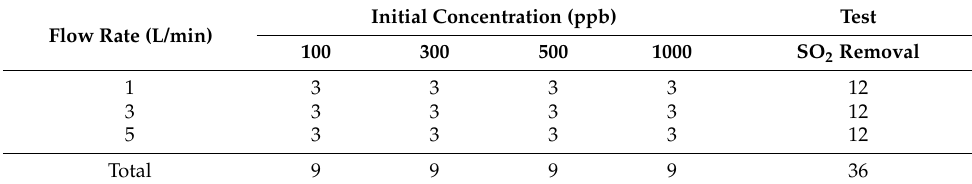
Table 9. Experimental